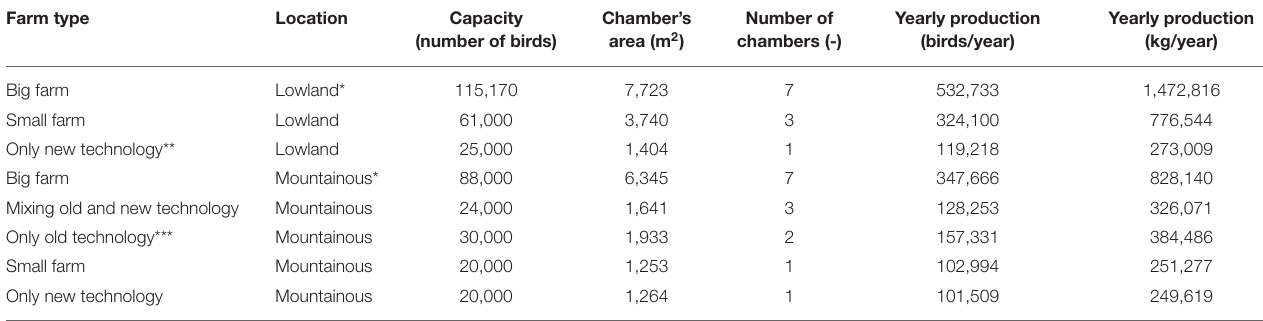
TABLE 1 | Description of the audited broiler facilities.